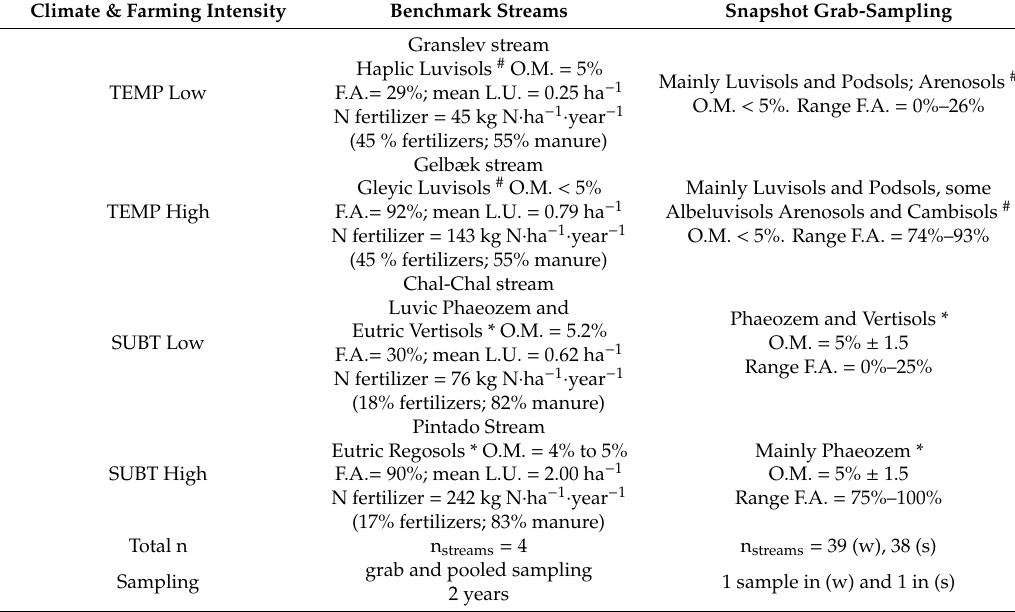
Table 1. Characteristics of the soil and land-use of all the studied stream catchments according to the sampling method used. Benchmark streams were sampled fortnightly using grab and automatized pooled